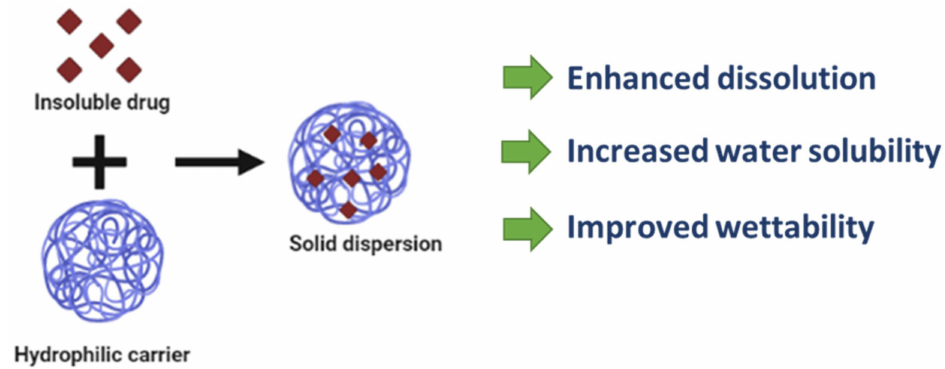
Figure 13. The formation of solid dispersion and the